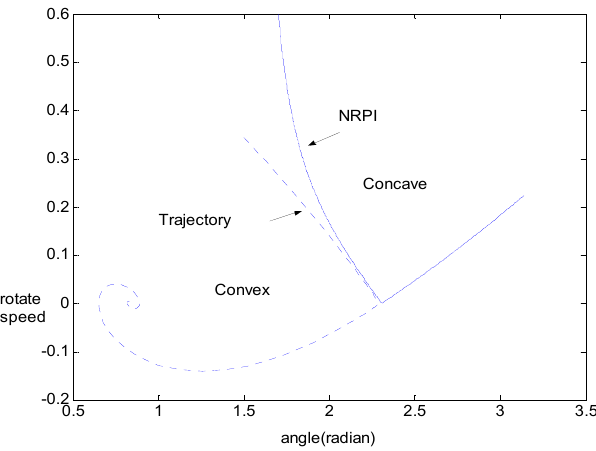
Figure 2. Relationship of NRPI and the critical post ‐ fault trajectory.